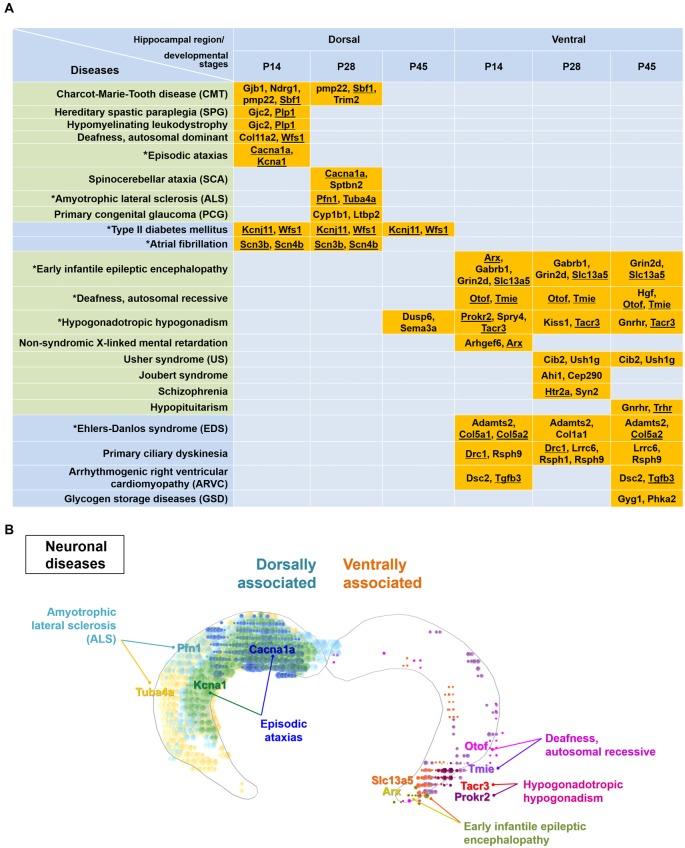
Particular disease-related genes are differentially expressed within either the dorsal or ventral hippocampus. (A) Genes enriched dorsally or ventrally in the hippocampus at each developmental age (Figure 3, Supplementary Table S1) were analyzed by the KEGG mapper program for disease search. Note that specific disease-related genes are distinctly segregated in the dorsal or ventral hippocampus, except for genes related to hypogonadotropic hypogonadism. Gene names are listed with the related diseases at individual developmental ages. Diseases presented in the green-shaded area are nervous system-related diseases. Underlined genes represent those enriched based on both the ABA in situ hybridization data and the RNA-seq data. Refer to Supplementary Figure S6 for the ABA in situ hybridization images for the underlined genes. Diseases marked with an asterisk were used to model the molecular domains related with specific diseases in (B) and Supplementary Figure S7. (B) Model for molecular domains related to neuronal diseases in the postnatally developing dorsal or ventral hippocampus. Based on the genes and their related diseases identified in this study in conjunction with the ABA in situ hybridization data, the spatial distribution of molecular domains related to the specific neuronal diseases was modeled. Only those molecules that share similar results between RNA-seq and ABA in situ hybridization analyses among the disease-related molecules in (A) were used for generating the molecular domains. Note that RNA-seq data were obtained from rat samples, whereas ABA in situ hybridization data were obtained from mouse samples. Refer to Supplementary Figure S7 for more information on the modeling of the spatial distribution of molecular domains related to non-neuronal diseases.